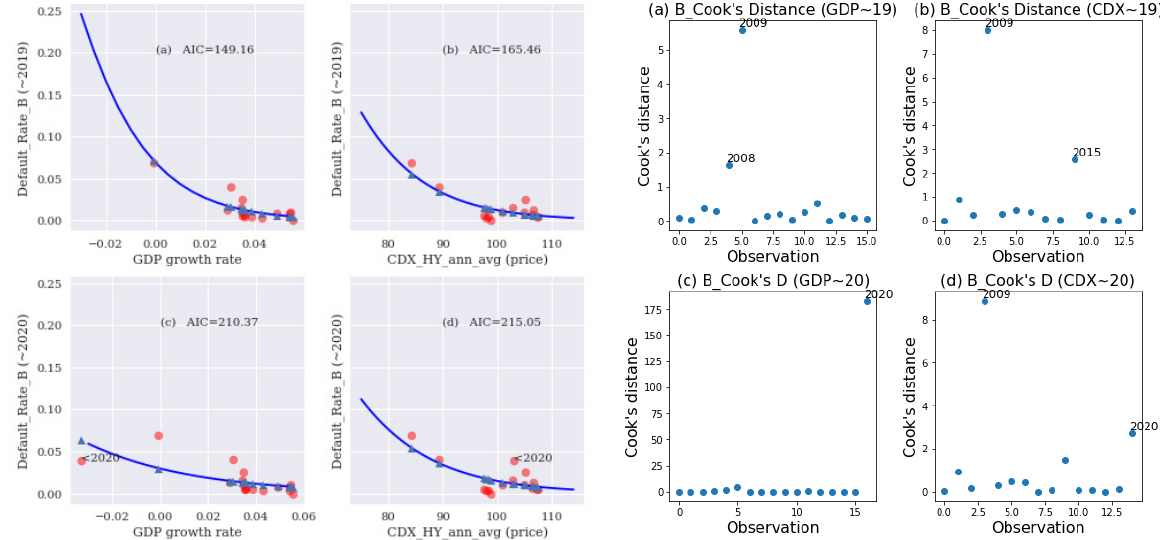
Figure 9. Fitted logistic regression models ( left panel ) and Cook’s distances ( right panel ) of default rate in relation to ( a ) GDP in 2006–2019 data; ( b ) CDX.NA.HY in 2006–2019 data; ( c ) GDP in 2006–2020 data; and ( d ) CDX.NA.HY in 2006–2020 data (price) for B class ratings.